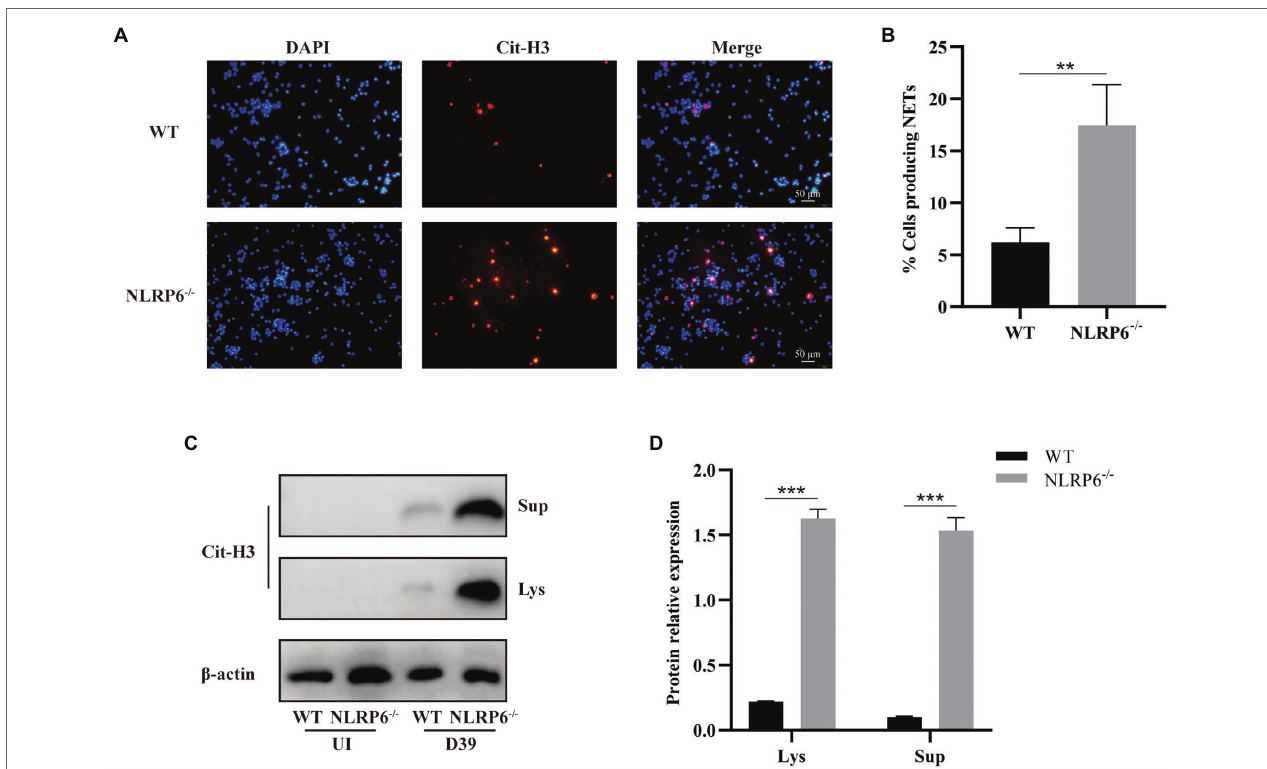
FIGURE 6 | NLRP6 inhibits formation of NETs of neutrophils. Neutrophils from WT and NLRP6 − / − were infected with S. pneumoniae at an MOI of 1 for 4 h. Immunofluorescent staining was to detect the expression of citrullinated-H3 (Cit-H3) which is the important component of NETs ( n = 3). The representative images of Cit-H3 are shown (A) . Quantification of neutrophils with NETs (B) . The culture supernatants and cell lysates were analyzed by western blot to detect expression of Cit-H3 ( C ; n = 3). Ratio of Cit-H3 levels against β -actin levels was quantified (D) . Statistical significance was shown as ** p < 0.01 and *** p <